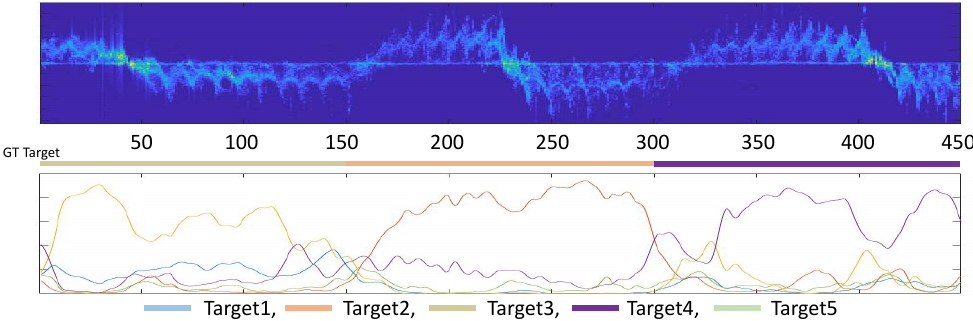
Figure 10. Extended experiment on MD signatures. The below distribution denotes time stamp wise target predictions, where this represents the availability of the human localization task of